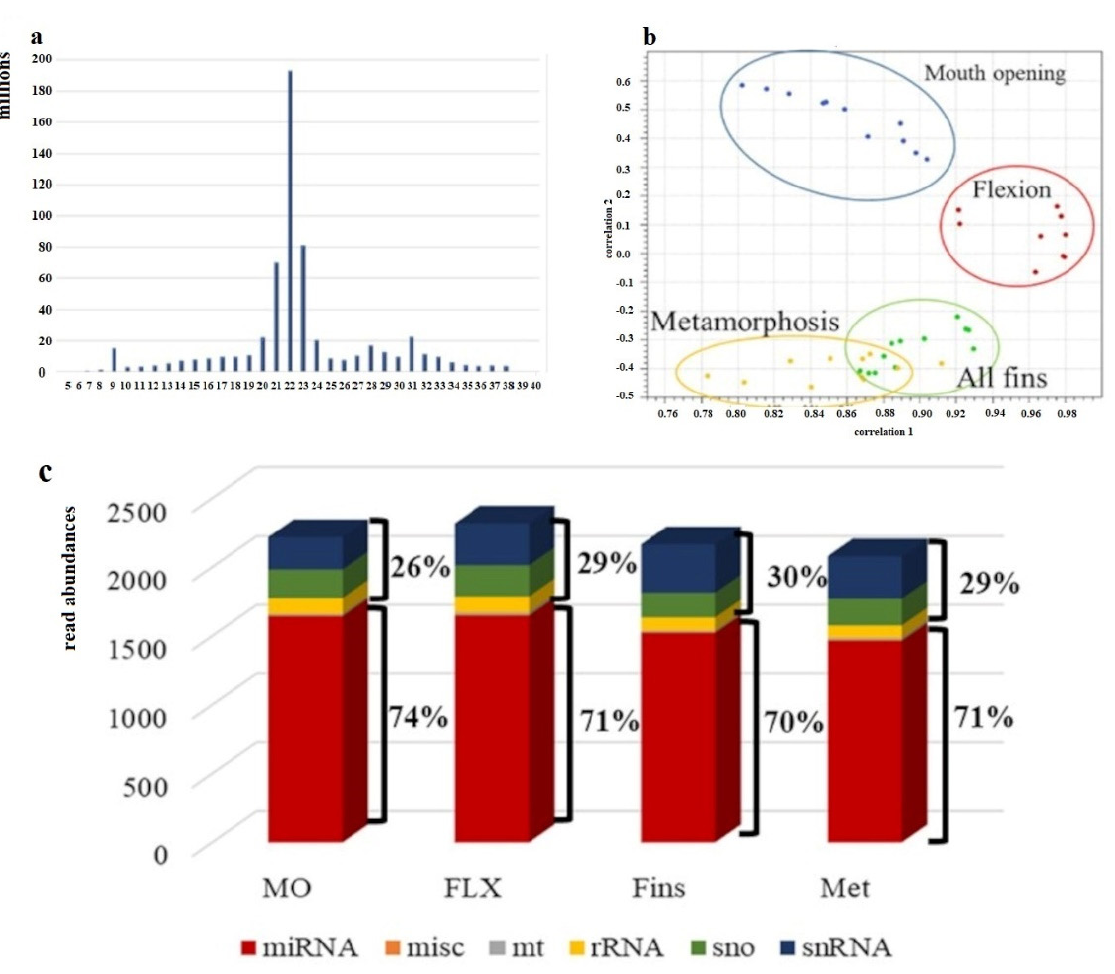
Figure 3. Evaluation of obtained sncRNA sequence reads. ( a ) Sequence length distribution. On the x-axes, the sequence lengths in nucleotides (nt) are plotted, and the y-axis shows the obtained number of counts of each sequence length. ( b ) PCA analysis of adapter- and quality-trimmed sequences according to their expression. ( c ) Annotation of sncRNA and their relative abundances are shown on the y-axis (n = 3 – 4).